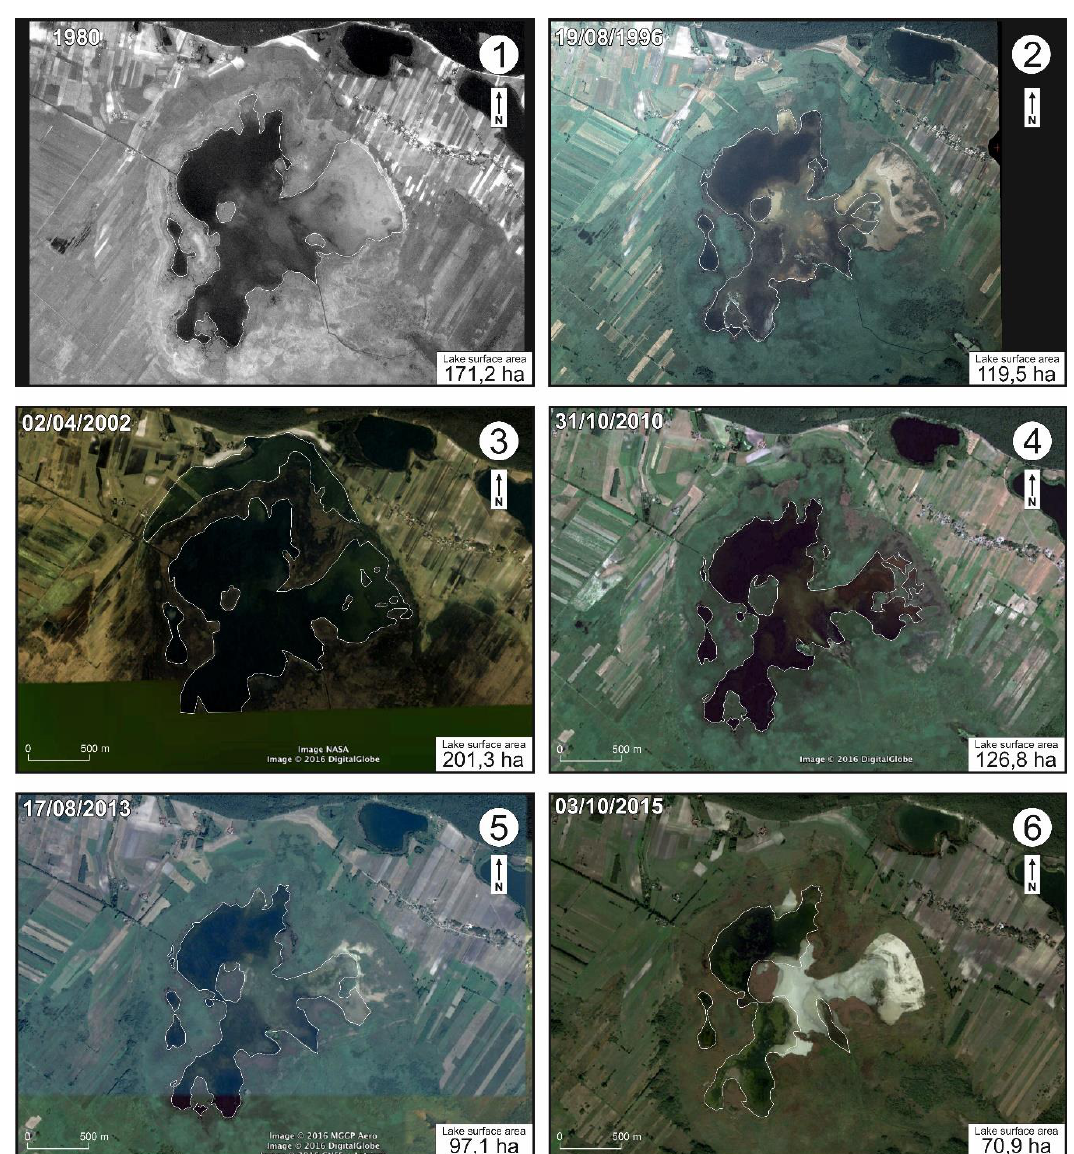
Figure 6. Satellite images presenting the range of Rakutowskie Lake corresponding to selected periods marked in Figure 5. The Figure is based on: 1. Panchromatic aerial photos 1:30,000; 2. RGB Photo 1:26,000; 3–6. Google earth 7.3.2.5491. Rakutowskie, Poland. 52°32’10.09” N, 19°14’25.17” E, Eye alt 3.44 km DigitalGlobe 2018. http://www.earth.google.com (1 October